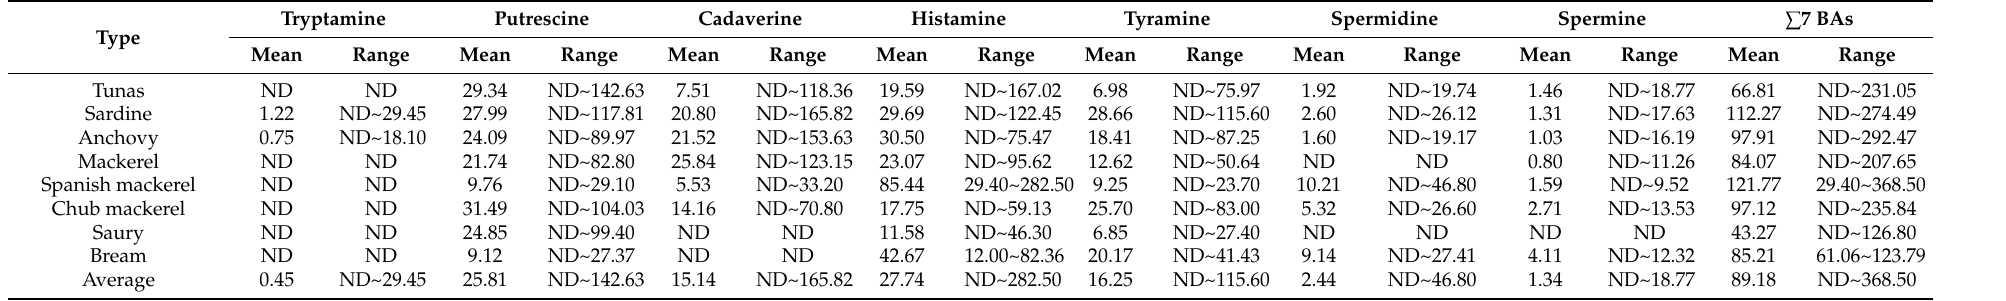
Table 2. Average value (mg/kg) and detection range (%) of 7 BAs in eight categories of canned sea fish samples ( n = 6).